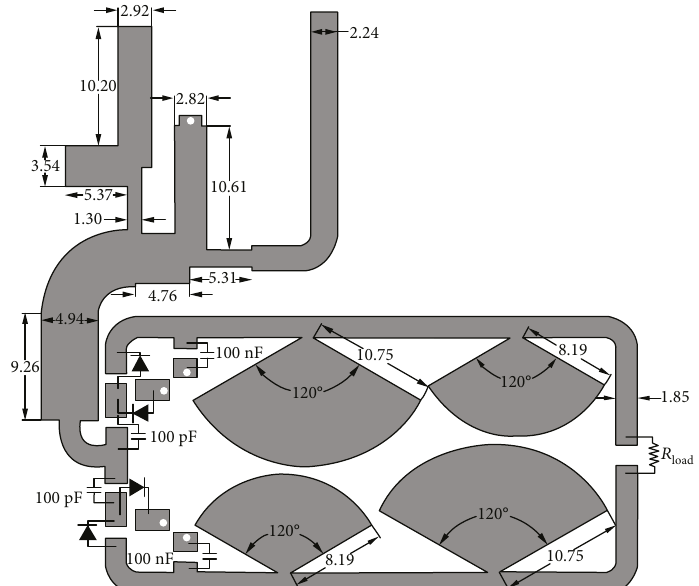
Figure 8: Layout of the proposed dual-band recti fi er (unit: mm).